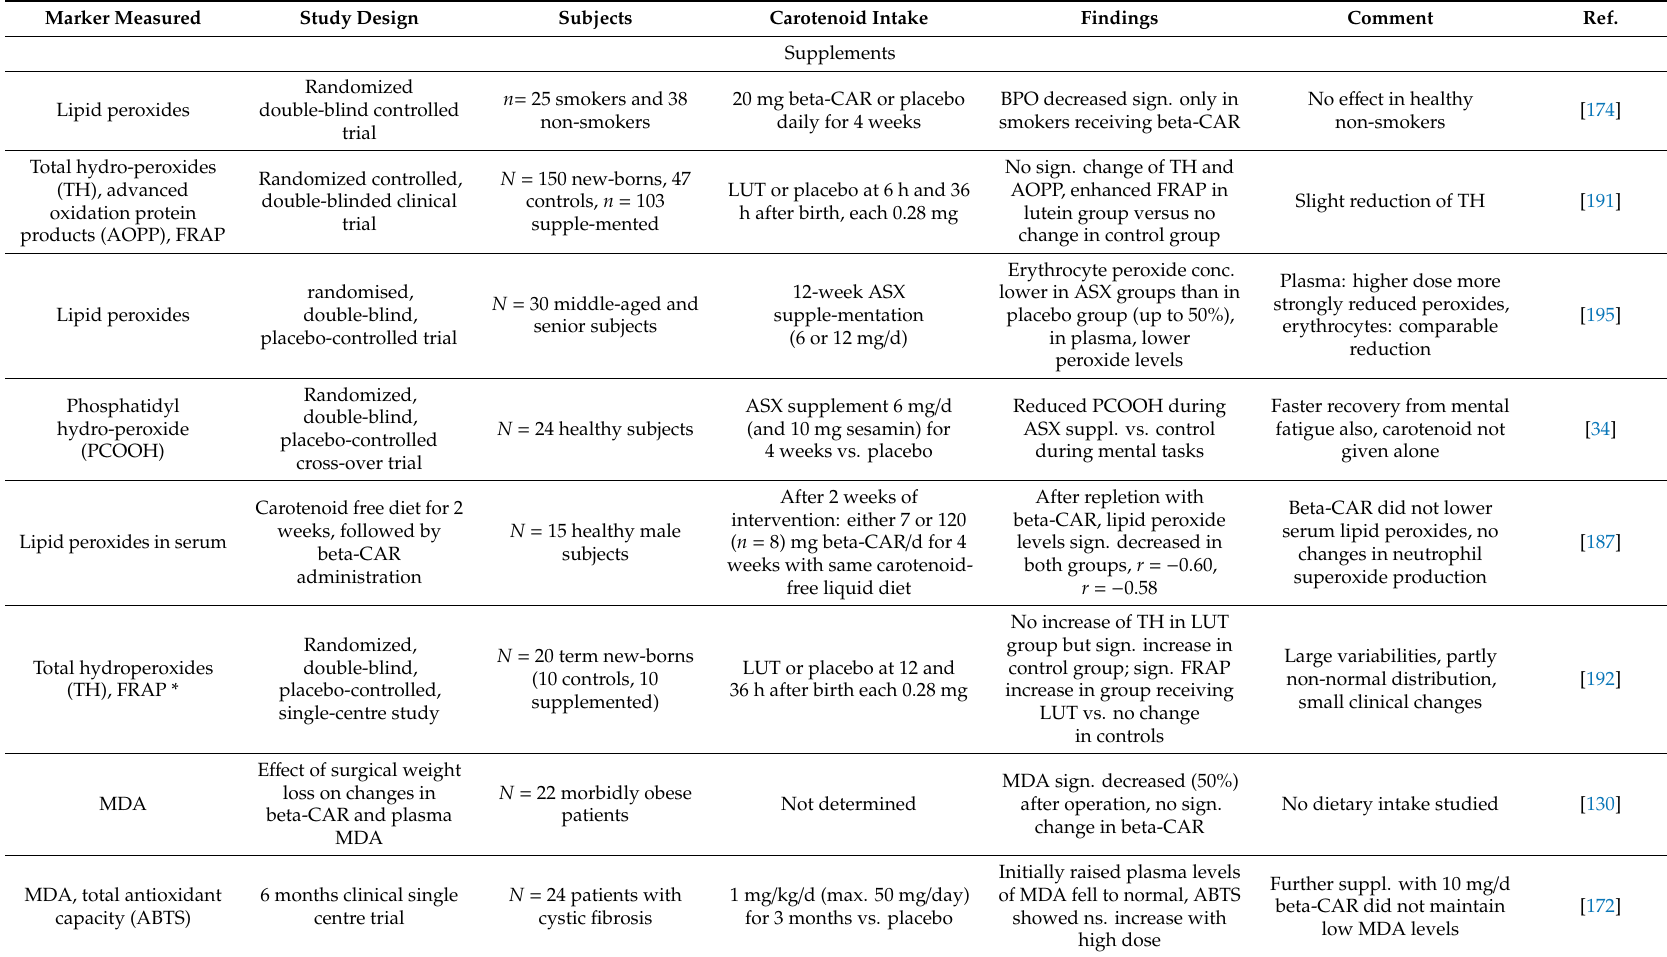
Table 4. Markers of oxidative stress in human intervention